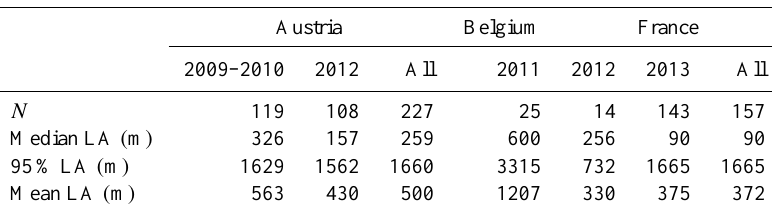
Table 2. LA in Austria (Region 1), Belgium (Region 2) and in France (Region 3) obtained from VFRS verified strokes which followed the same channel as a previous stroke in the flash.